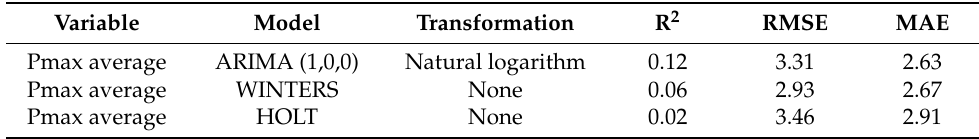
Table 6. Maximum rainfall recorded in 24 h of each month averaged by year, models, and adjust- ment